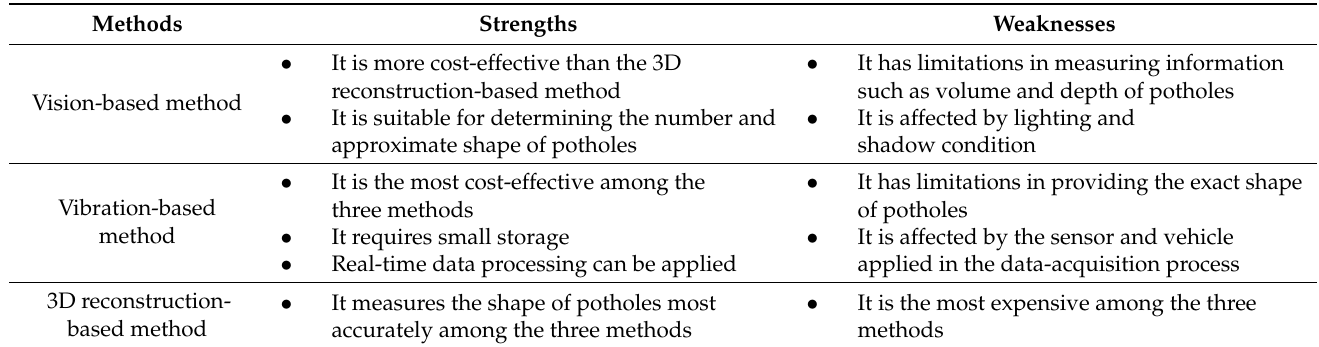
Figure 2. The characteristics of automated pothole-detection methods. Table 1. The strengths and weaknesses of automated pothole-detection methods.